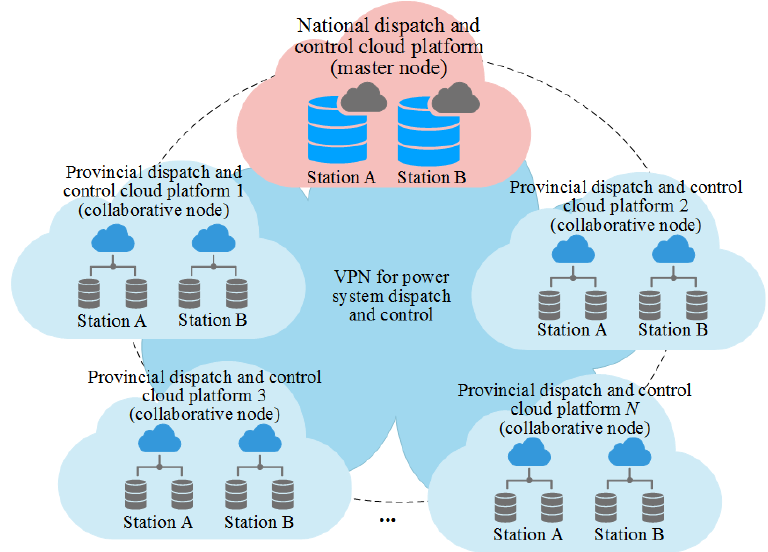
Figure 8. Schematic diagram of the cloud platform of the China state grid.